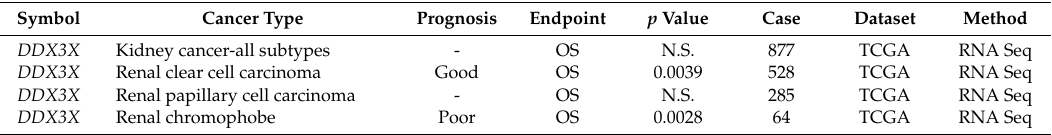
Table 1. The correlation of DEAD (Asp-Glu-Ala-Asp) box polypeptide 3, X-linked (DDX3X) with cancer patient survival.